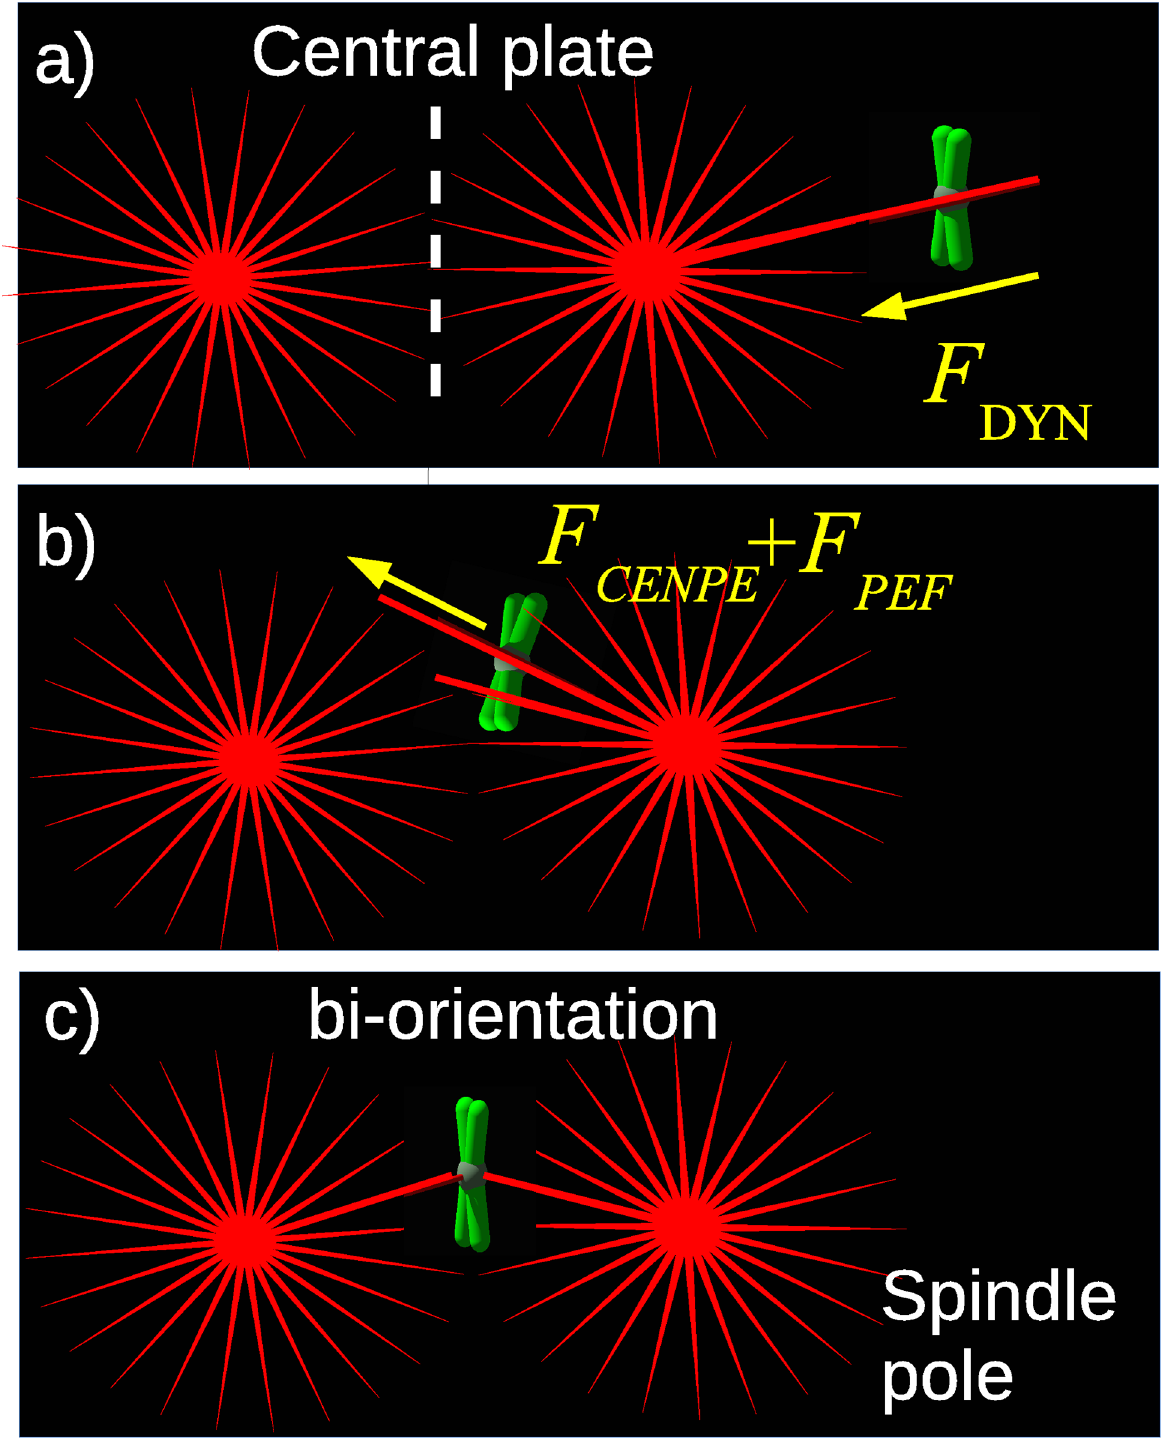
Fig 1. Schematic of the dynamics of a single chromosome. a) Peripheral chromosomes, not lying between the spindle poles, are driven to the nearest pole by dynein. b) Chromosomes are driven from the pole to the central plate by the combined action of CENP-E and PEF. c) At the central plate, chromosomes attached to both poles are called